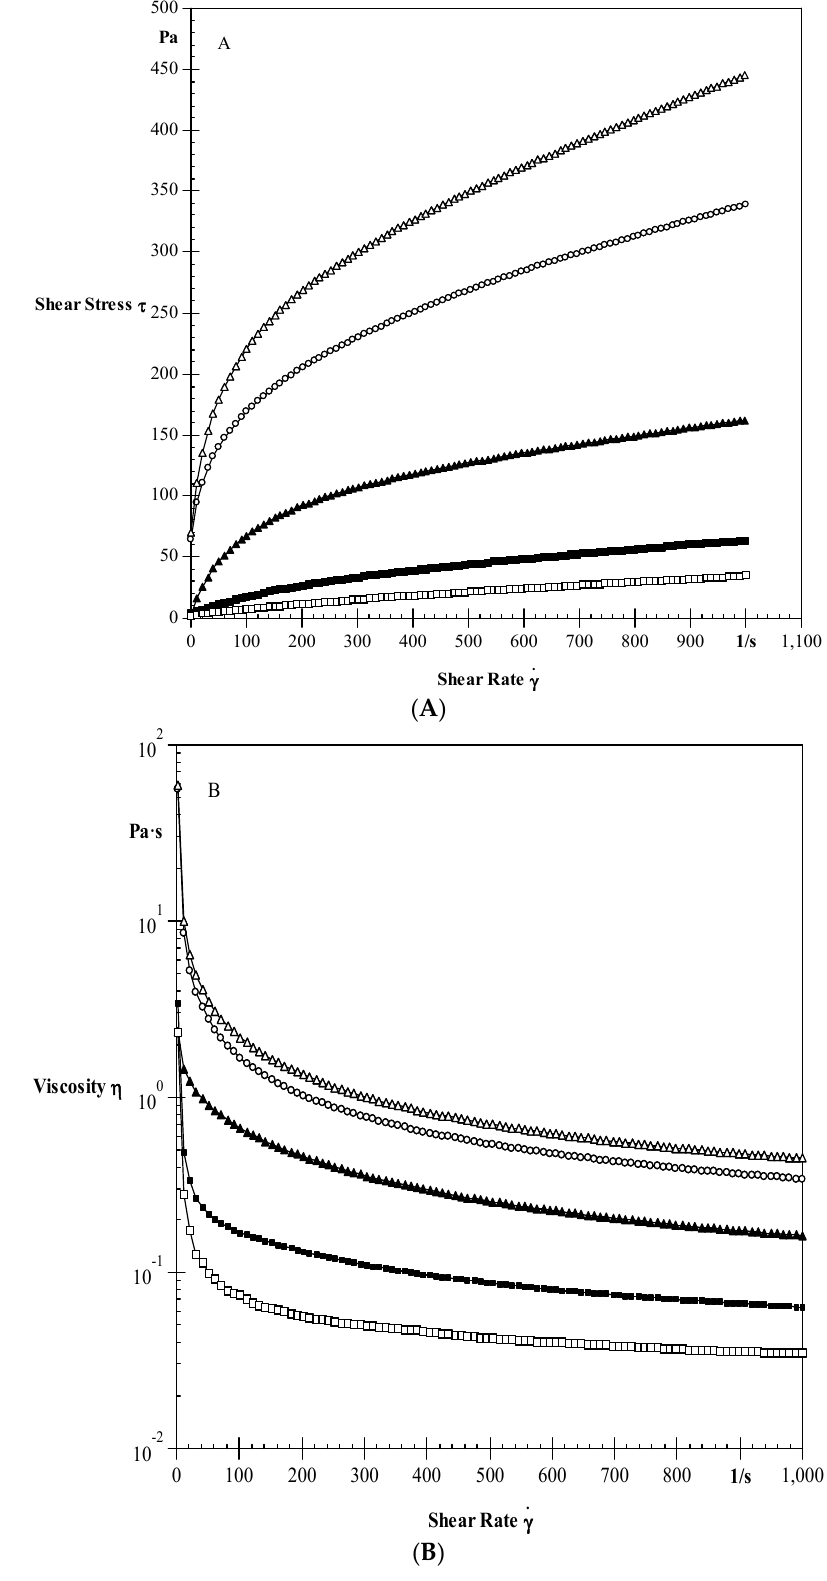
Figure 2. ( A , B ) Steady shear properties of native and modified starches. Samples are denoted by o-Native; ∆ -(Cross-linking at 0.1%); ▲ -(Cross-linking at 0.3%); ■ -Cross-linking at 0.5%); □ -(Cross-linking at 0.8%).